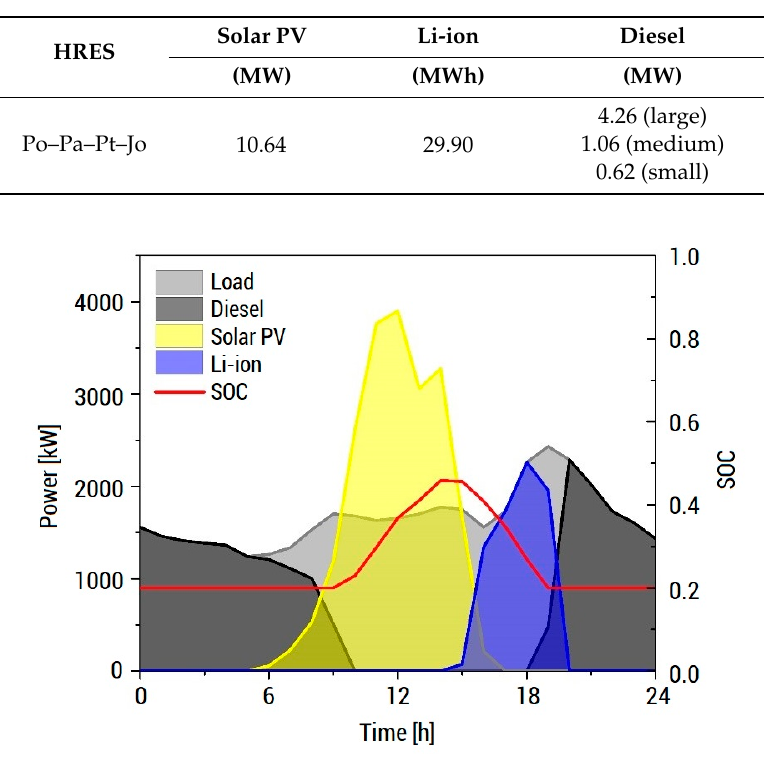
Figure 10. Power flow of the more reliable HRES when half of the solar capacity fails.